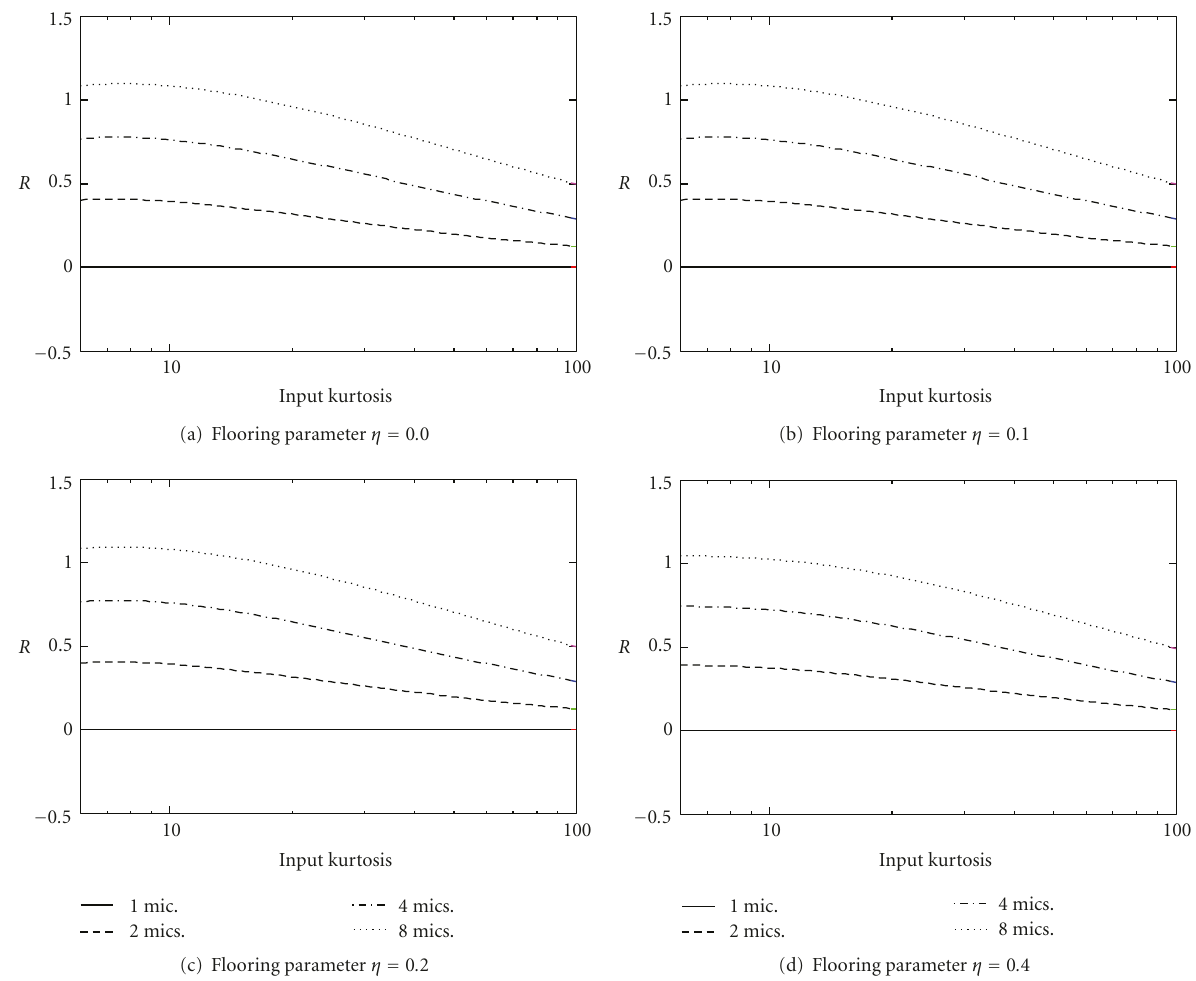
Figure 12: Theoretical kurtosis ratio between BF+SS and chSS+BF for various values of input kurtosis. In this figure, oversubtraction parameter is β = 2 . 0 and flooring parameter in chSS+BF is (a) η = 0 . 0, (b) η = 0 . 1, (c) η = 0 . 2, and (d) η = 0 . 4.